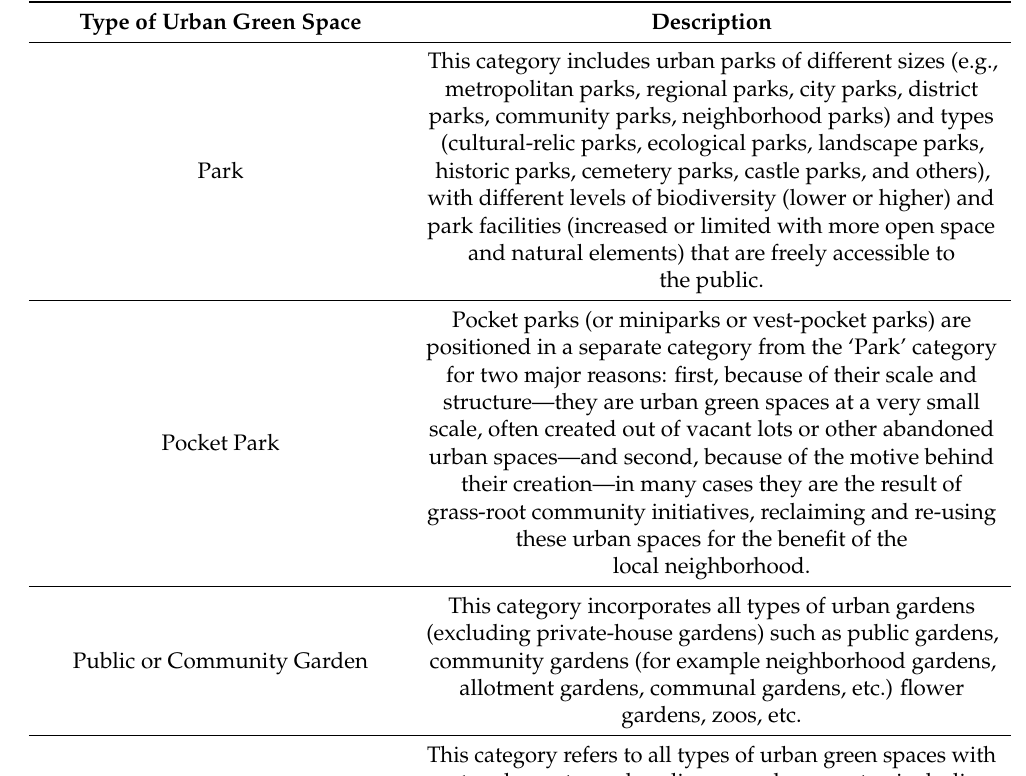
Table 1. Inventory of Urban Green Space